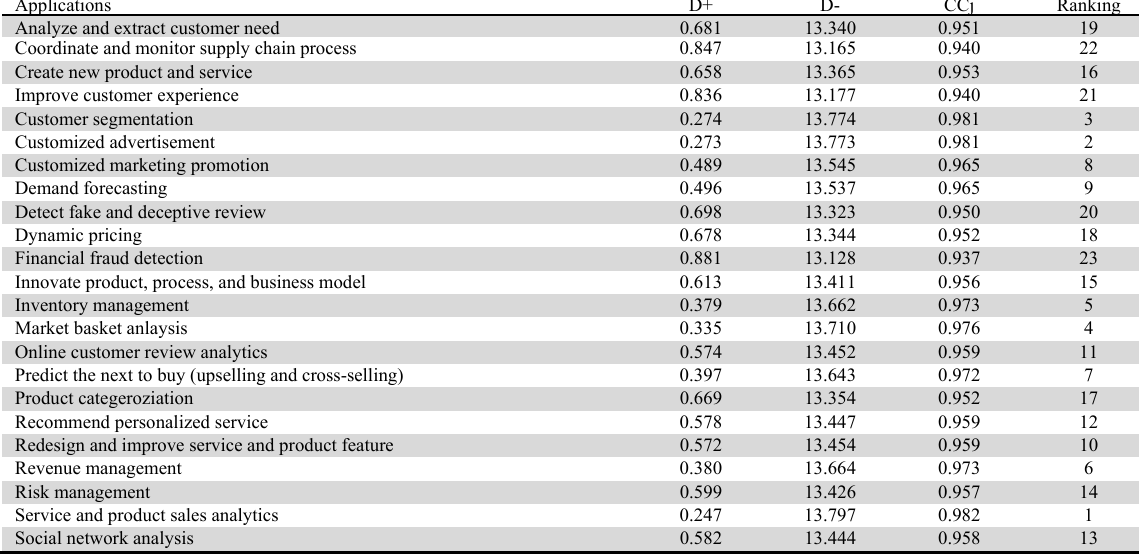
Table 8 Final rankings of big data applications based on